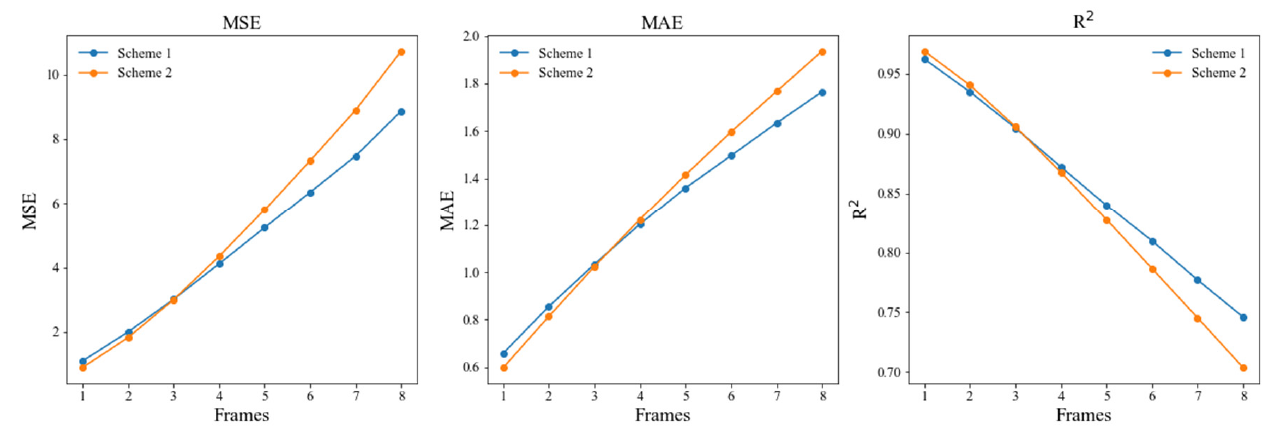
Figure 6. The quantitative evaluation metrics of the Band 9 prediction results. Table 2. The mean values of the quantitative evaluation results of the two prediction schemes.